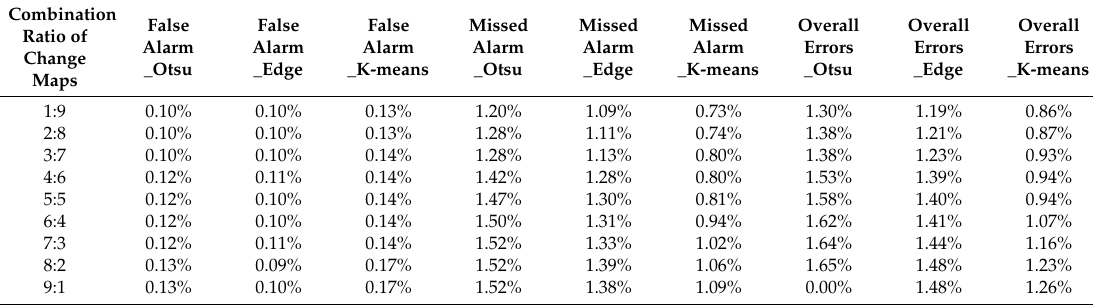
Table 4. Comparison between the change detection results of the three thresholding and clustering methods, with L2 as the basis image in the first study area (scale =